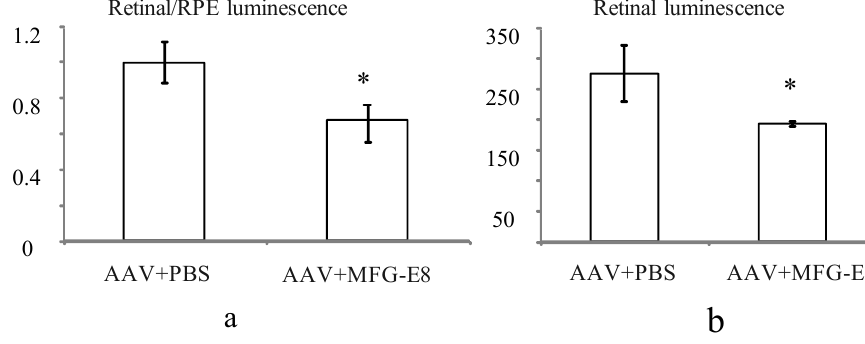
Figure 5. ( a ) Effect of MFG-E8 on the luminescence profile (retinal luminescence)/(RPE luminescence), following co-subretinal injection with AAV-luciferase in adult mice (n = 9), p = 0.03. Overall the ratio of retina to RPE transduction is reduced when MFG-E8 is present in the viral adjuvant. The retinal luminescence ( b ) shows the absolute reduction in retinal transduction due to MFG-E8, p =